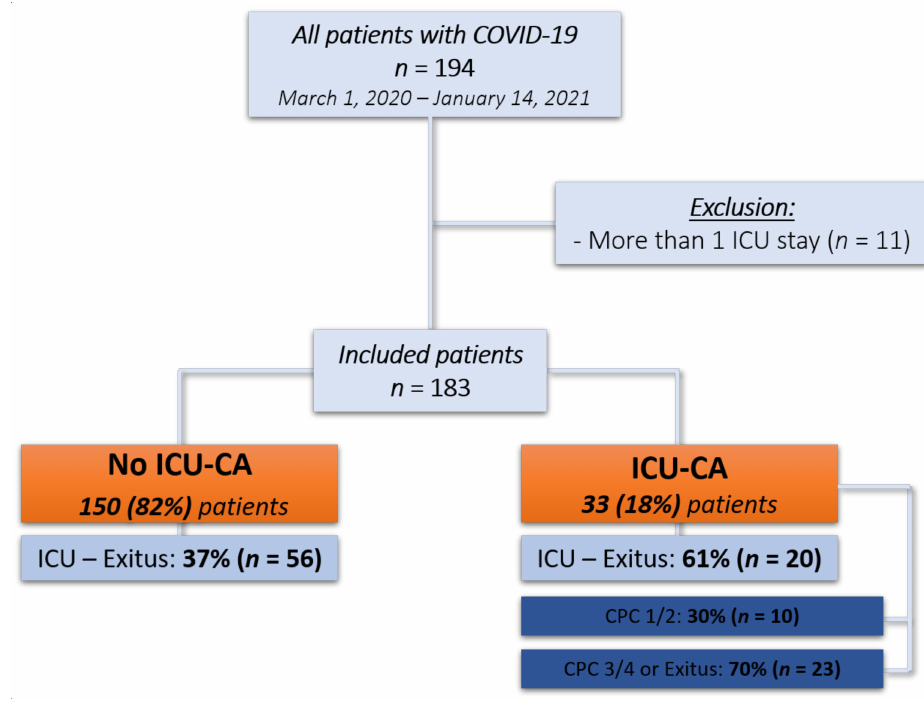
Figure 1. Study flow chart. Table 1. Baseline and ICU-characteristics of patients stratified according to ICU cardiac arrest (ICU-CA) and no ICU cardiac arrest (no